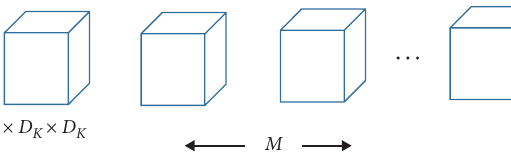
Figure 8: Filters by convolution based on [7].